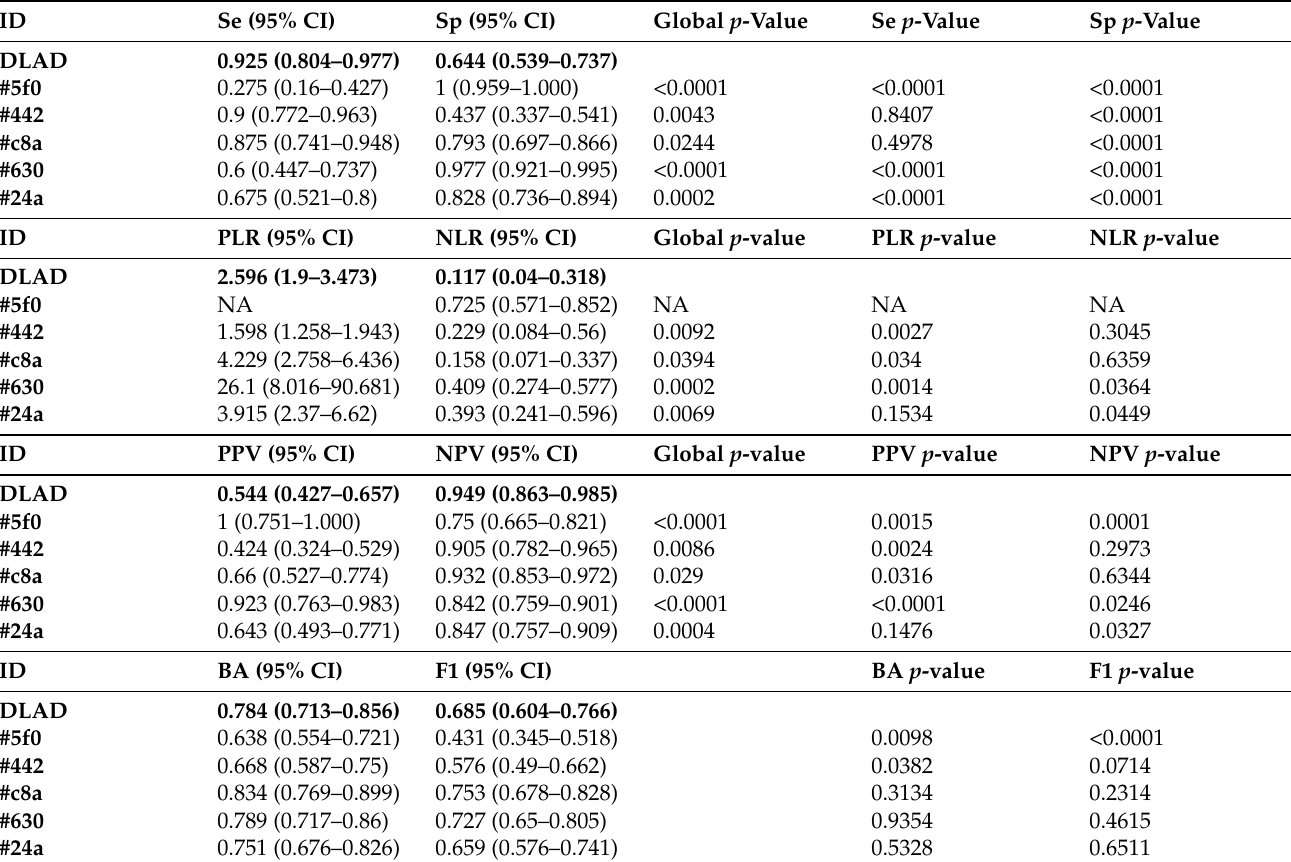
Table 6. Performance of individual radiologists compared to